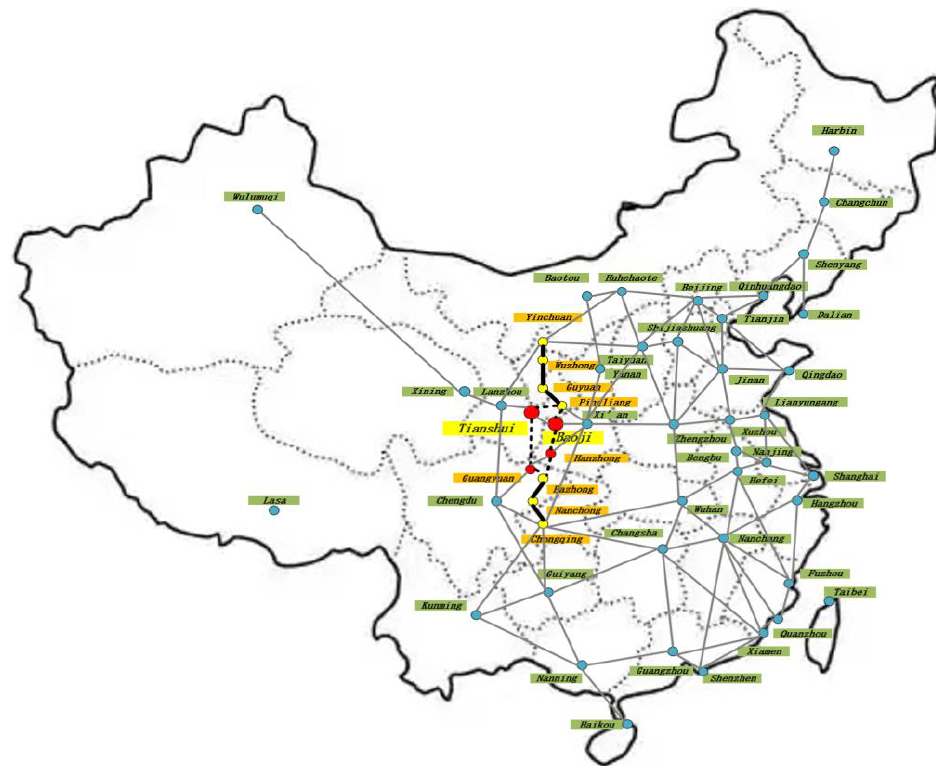
Figure 1. Schematic diagram of the forecast of the Yinchuan–Chongqing high-speed railway (HSR) station.